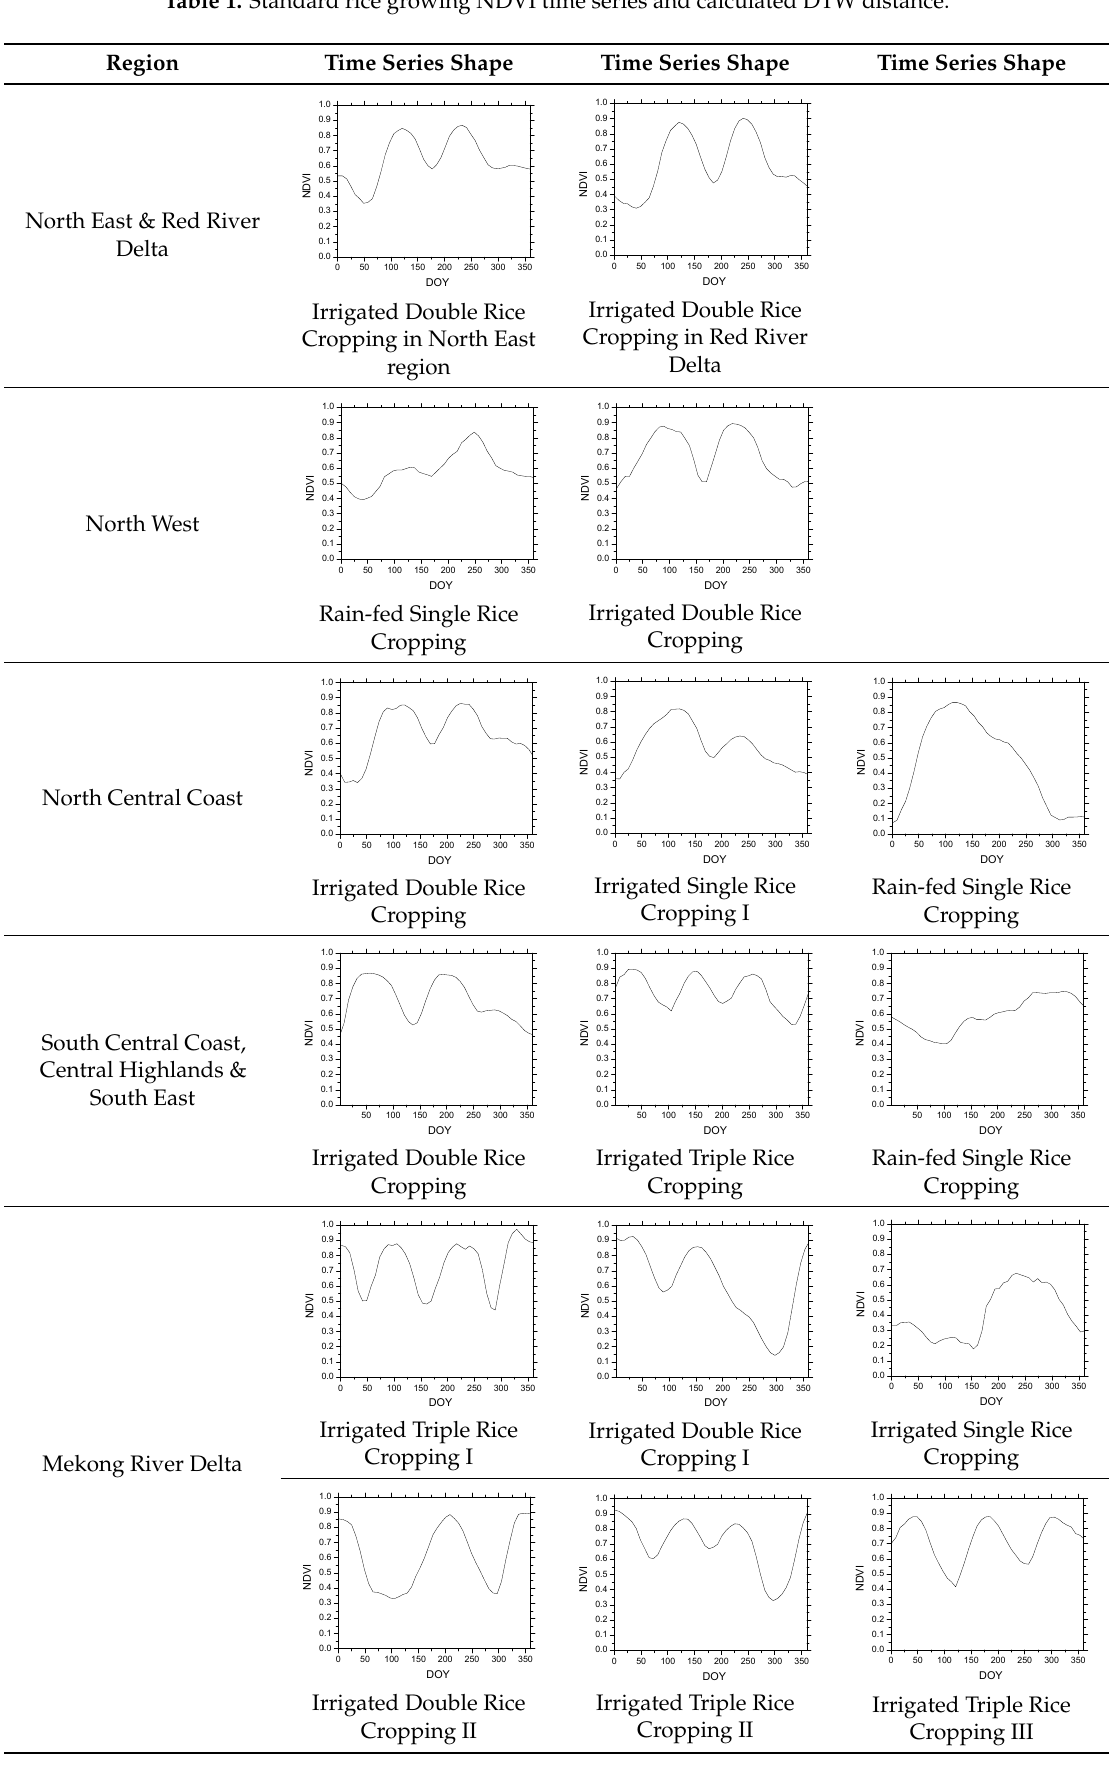
Remote Sens. 2016 , 8 , 19 10/25 5. Results 5.1. Standard NDVI Time-Series Base and DTW Distance For the purpose of getting standard rice growth NDVI time-series, we acquired 366 rice field points and composed a standard rice growth NDVI time-series base as the reference NDVI time series. Among the 366 sampled rice field points, a total of 92 sampled rice field points were located in the North Central Coast, 86 in the Mekong River Delta, 67 in the South Central Coast, 41 in the Red